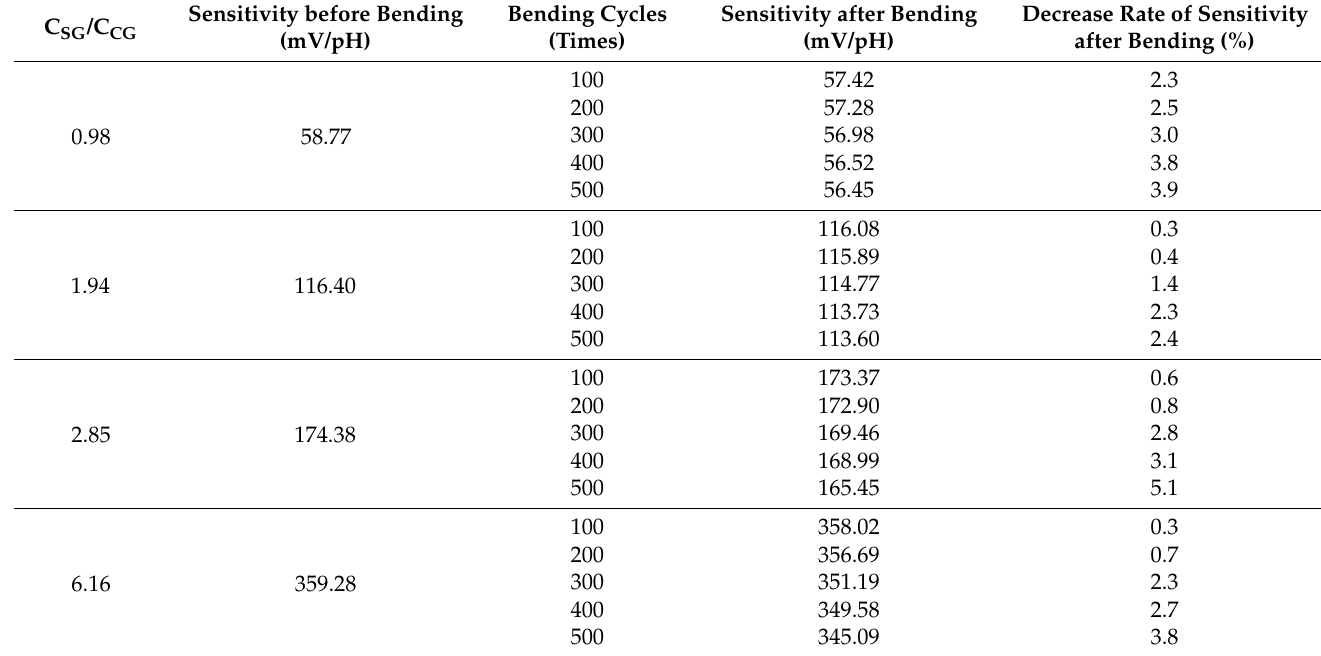
Figure 7. ( a ) Image of an a-IGZO coplanar dual-gate TFT converter unit on a PI substrate bent to a diameter of 3 mm using vernier calipers. The inset shows an optical microscope image obtained after the bending test. Transfer characteristic curves after 500 bending cycles to a diameter of 3 mm for C SG /C CG values of ( b ) 0.98 and ( c ) 6.16. ( d ) pH sensitivity for various C SG /C CG values after repeated bending tests (I Read = 1 nA). Table 3. PH-sensing characteristics obtained from the bending test of the a-IGZO coplanar dual-gate TFT.